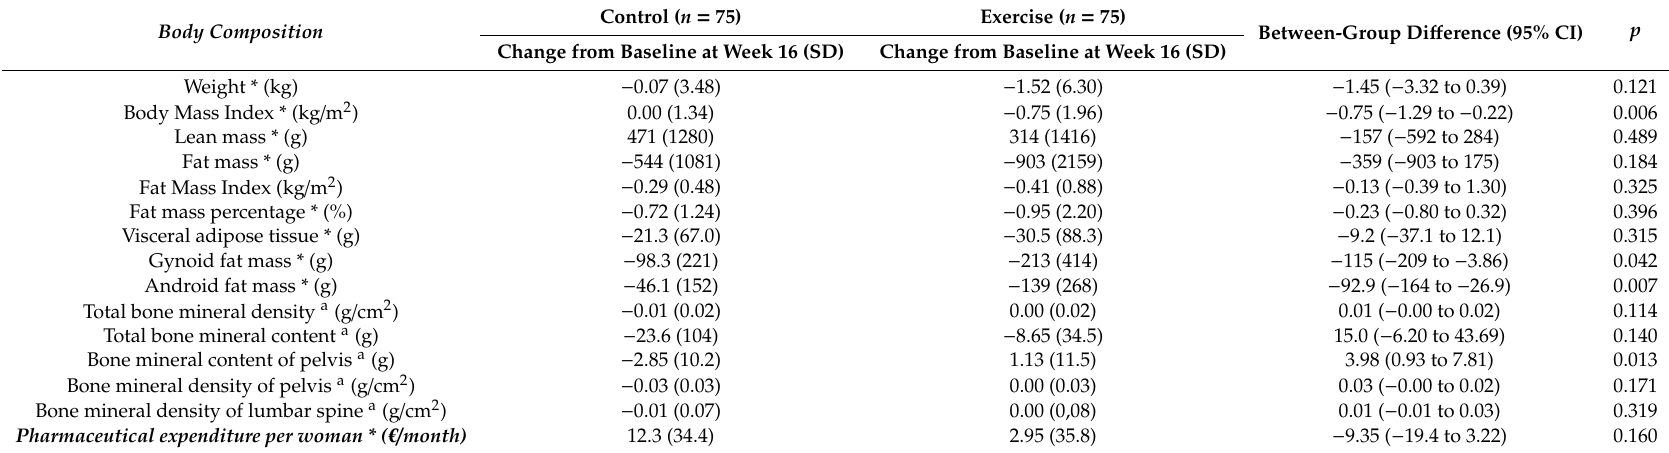
Table 2. Intention-to-treat analyses showing the e ff ect of a 16-week concurrent exercise program on body composition in perimenopausal women ( n =